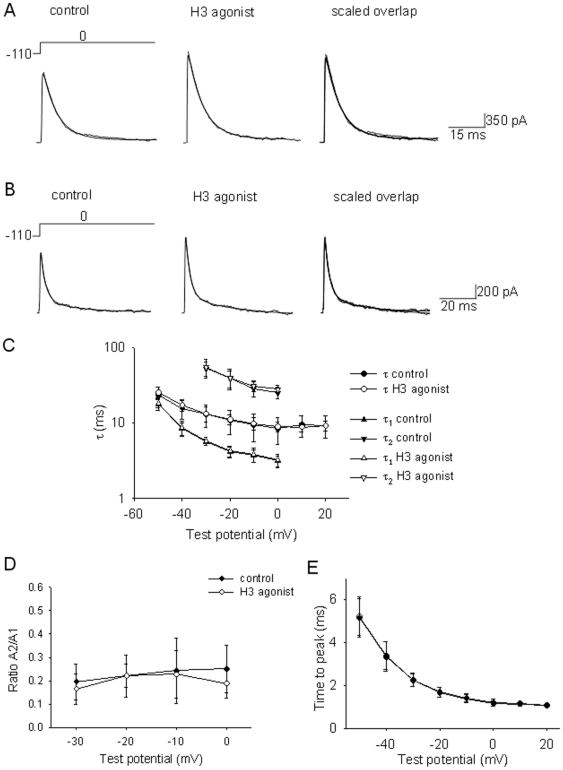
Lack of effect of H3 agonist on IA kinetics in GABAergic preoptic neurons.A,B. IA recorded from two w-t neuron in control (left), after 5 min incubation with R-α-methylhistamine (1 µM) (middle) and their scaled overlap (right). The currents were elicited by the voltage steps to 0 mV from a holding potential of −110 mV. The extracellular solution contained TTX (1 µM), TEA (5 mM) and 4-AP (0.25 mM). The traces in A were fitted by a single exponential decay A*e(−t/τ). T was 10.3 ms in the control and 10.6 during H3 agonist incubation. The currents in B were fitted with a biexponential decay A1*e(−t/τ1)+A2*e(−t/τ2). T1 was 2.9 ms in the control and 3.0 ms during H3 agonist incubation. T2 was 29.4 ms in the control and 28.9 ms during H3 agonist incubation. C. Voltage-dependence of the time constants of IA decay. Some cells displayed monoexponential decay (τ) (n = 6) or biexponential decay (τ1 and τ2) (n = 4) in control (black) and during H3 agonist incubation (white). The data points at +10 and +20 mV are from 4 neurons dispaying monoexponential decay. D. Voltage-dependence of the A2/A1 ratio of neurons that displayed biexponential decays (n = 4) in control (•), and during H3 agonist incubation (○). E. Voltage-dependence of the time to peak of IA (n = 10) in control (•), and during H3 agonist incubation (○). C–E. Data are presented as averages ± S.D.